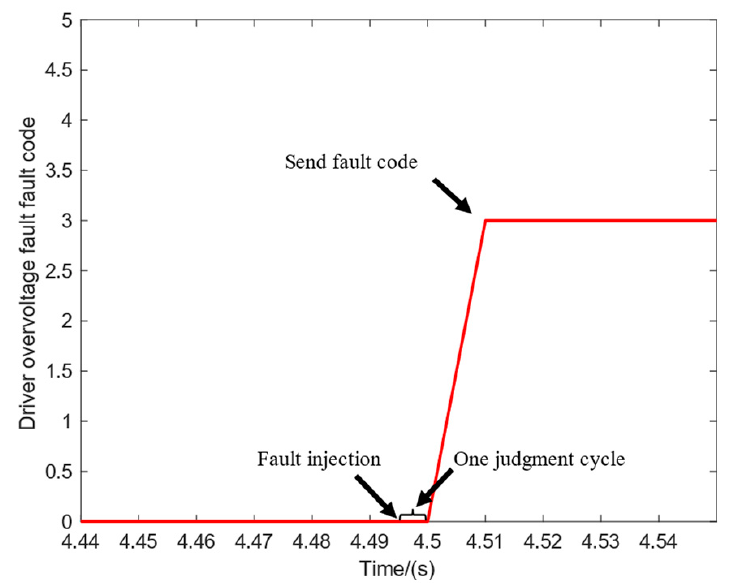
Figure 16. Driver overvoltage fault code diagram.